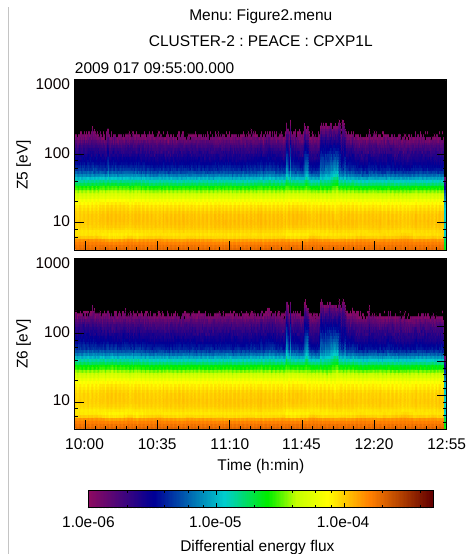
Figure 2. Spectrograms of the PEACE elevation zones above and below the ecliptic plane. This is basically solar wind with some foreshock. Bursts of intense high-energy electrons above 40eV cor- respond to periods when the spacecraft are in the foreshock. The bursts occur due to the addition of higher-energy return electrons that have been backscattered off of, or leaked through, the shock.